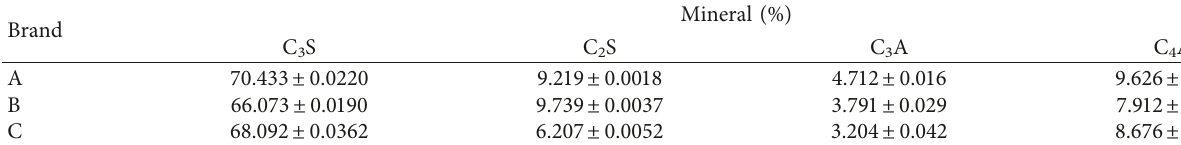
Table 2: Results for the Bogue calculation of the test